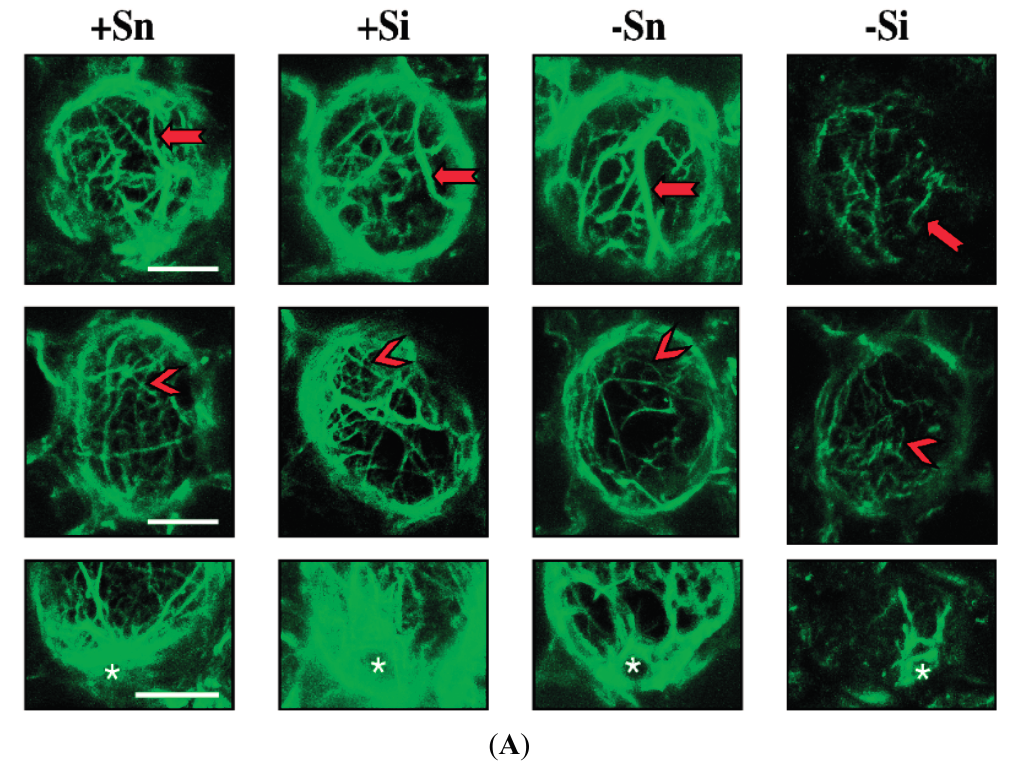
Figure 7. The effect of sucrose and F. oxysporum on actin ( A ) (scale = 20 µm) and tubulin ( B ) (green fluorescence; scale = 10 µm) cytoskeleton organization in vitro cultured embryo axes of L. luteus . The red arrow indicates actin cables, red arrowhead-meshwork of microfilaments and white star-actin cytoskeleton around the